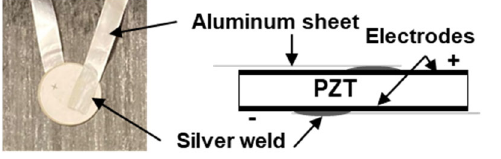
Figure 2. PZT connecting method with a silver weld and an aluminum sheet.